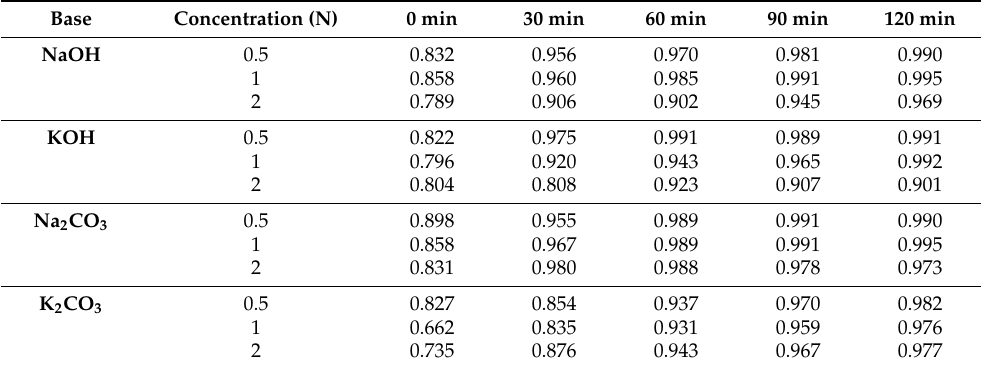
Table 1. Optimization of base concentrations for the FB assay carried out at different incubation times. The average R 2 results represented below are calculated by the values obtained from the simple linear regression coefficients (R 2 ) of four replications. Absorbance of the plates were recorded at 420